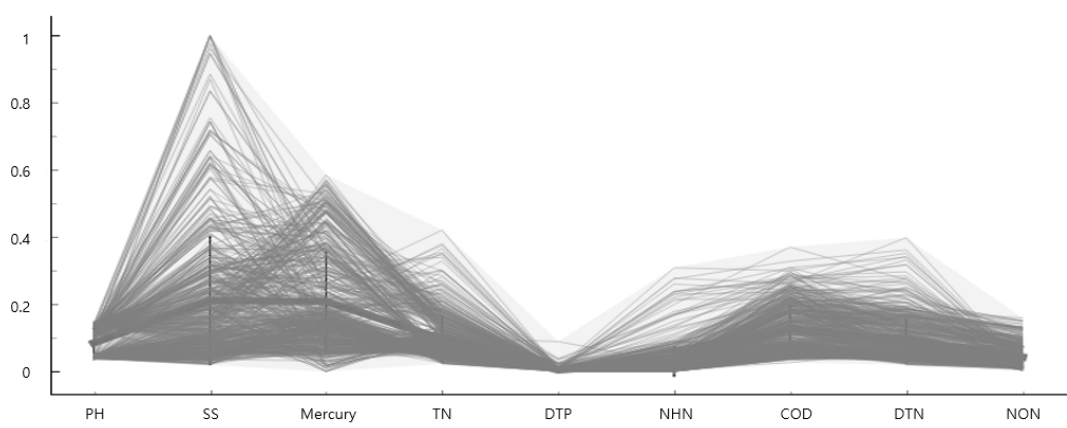
Figure 8. Train output line plot.